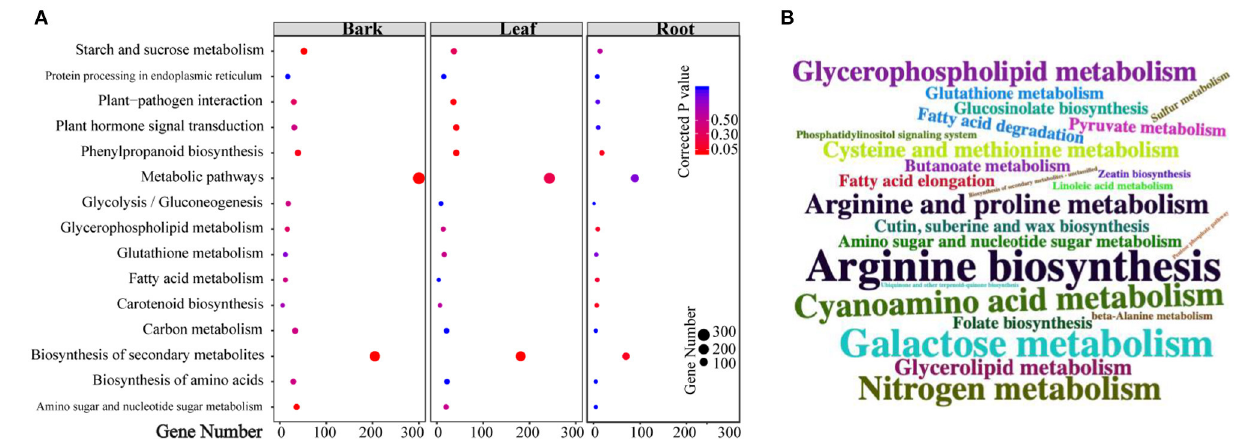
FIGURE 3 | Kyoto Encyclopedia of Genes and Genomes (KEGG) pathway enrichment analysis of differentially expressed genes (DEGs) and differentially accumulated metabolites (DAMs). (A) Pathways that enriched top10 gene numbers in each comparison between C Las-infected and healthy tissues; (B) pathways that enriched detected metabolites: larger size means more metabolites were detected in this pathway.